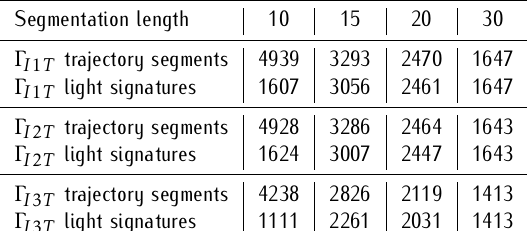
With changing baseline between distributions